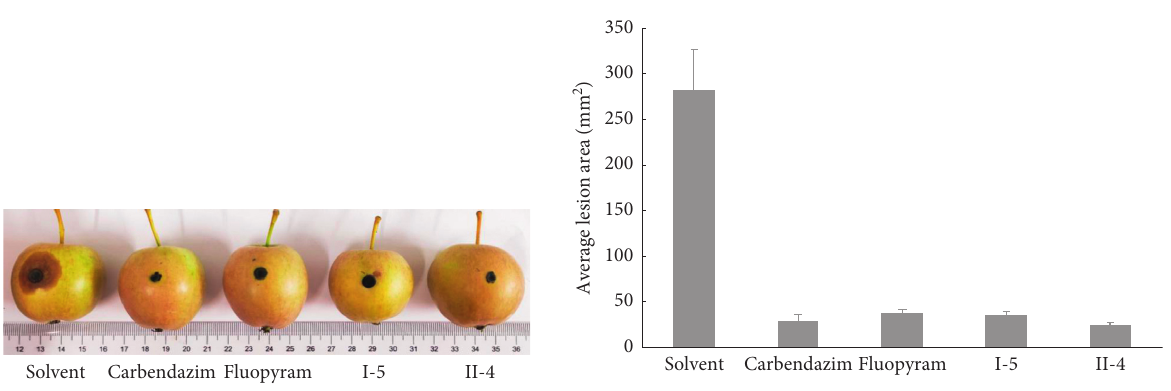
Figure 5: In vivo fungicidal activity of compounds I-5 and II-4 against Physalospora piricola -infected apples at 200 μ g · mL − 1